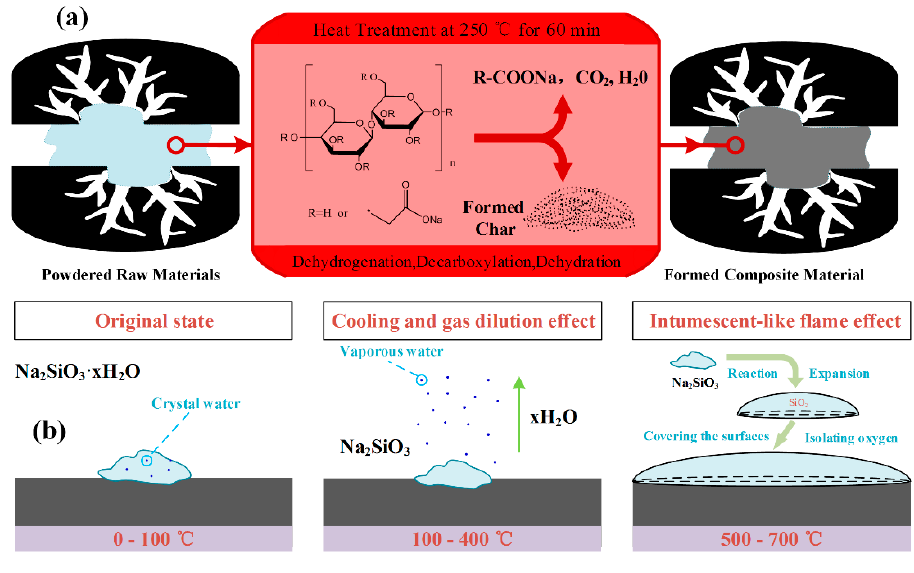
Figure 3. ( a ) Schematic diagram of molding mechanism. ( b ) Schematic diagram of flame-retardant mechanism.